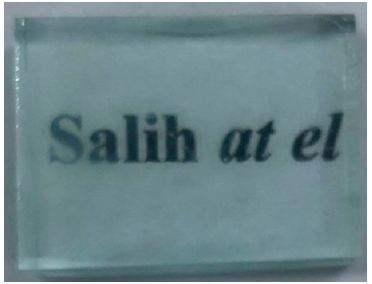
Figure 5. Digital image of the fabricated T-400 MMO film.